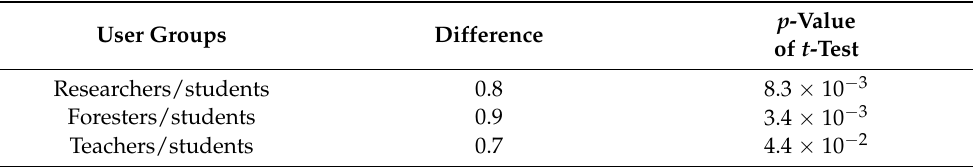
Table A2. Significant differences in desktop computer use between students and the other user groups.